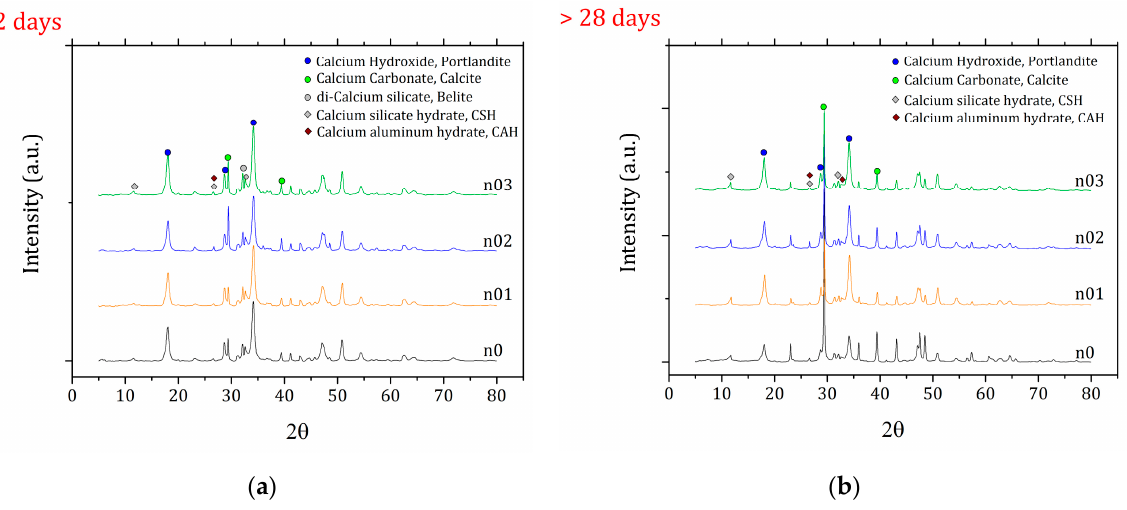
Figure 7. XRD pattern of the four pastes at 2 d ( a ) and after 28 d of curing ( b ).